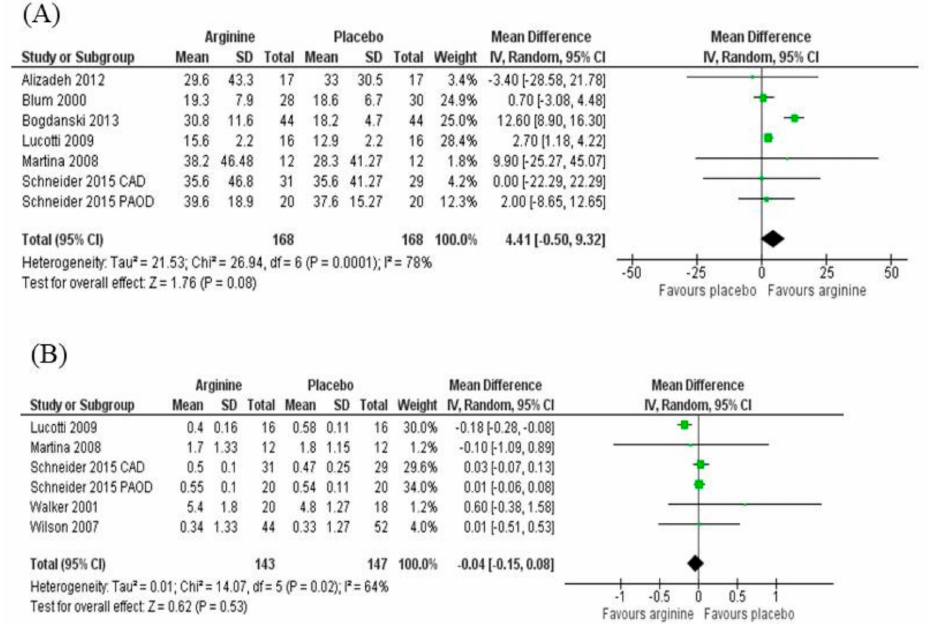
Figure 4. ( A ) NOx and ( B ) ADMA responses of individual studies: L -arginine vs. placebo